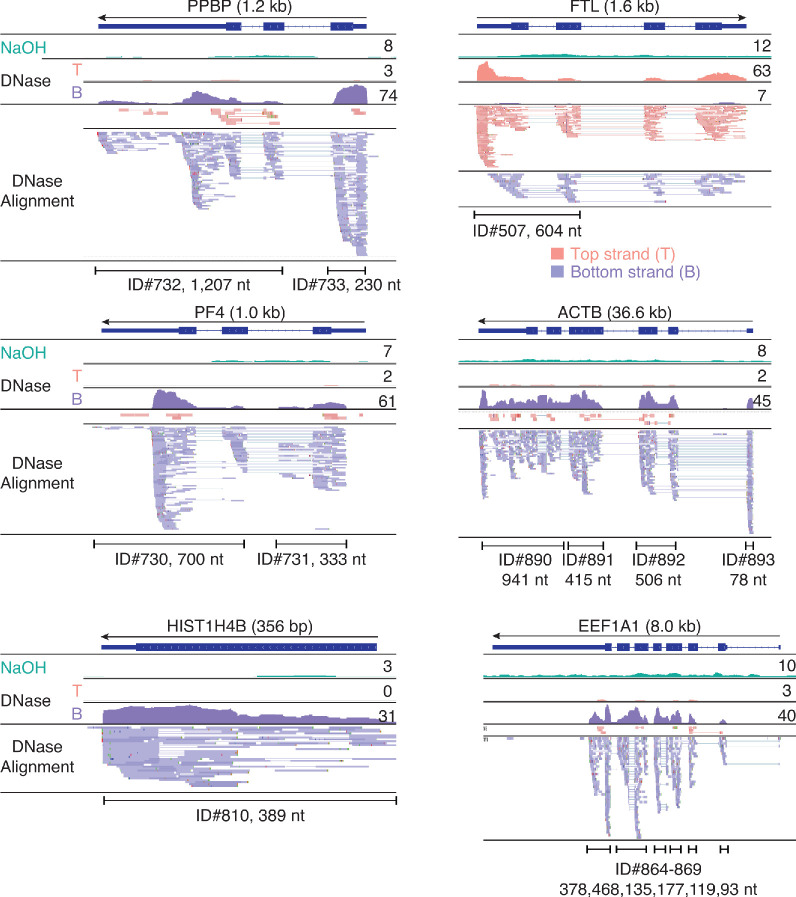
IGV screenshots showing examples of peaks consisting of heterogenous RNA fragments extending across protein-coding gene exons.Gene names are indicated at the top with the length of the gene indicated in parentheses and an arrow below indicating the 5’ to 3’ orientation of the encoded mRNA. IGV coverage plots and alignments are labeled as in Figure 7 with the peak called by MACS2 delineated by the bracketed line with the peak ID number and length indicated below. The antisense reads in the FTL gene (top right) are discussed further in Figure 13—figure supplement 1 below.